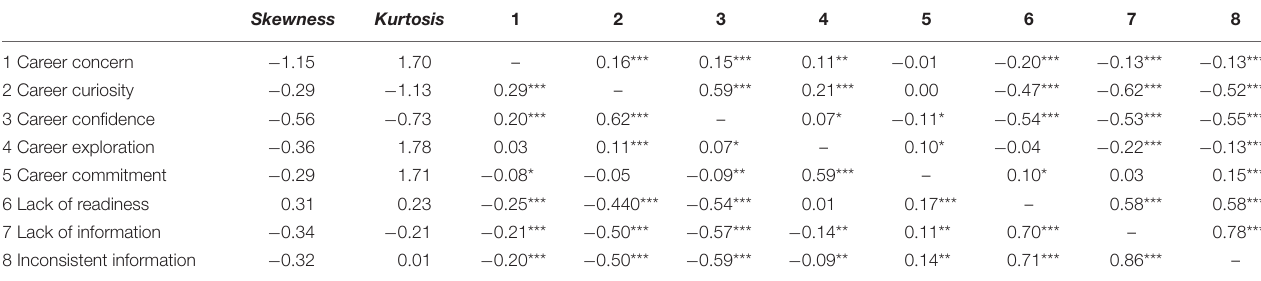
TABLE 2 | Zero-order correlations between the career maturity scale, career decision-making difficulties scale, and vocational identity status assessment. Skewness Kurtosis 1 2